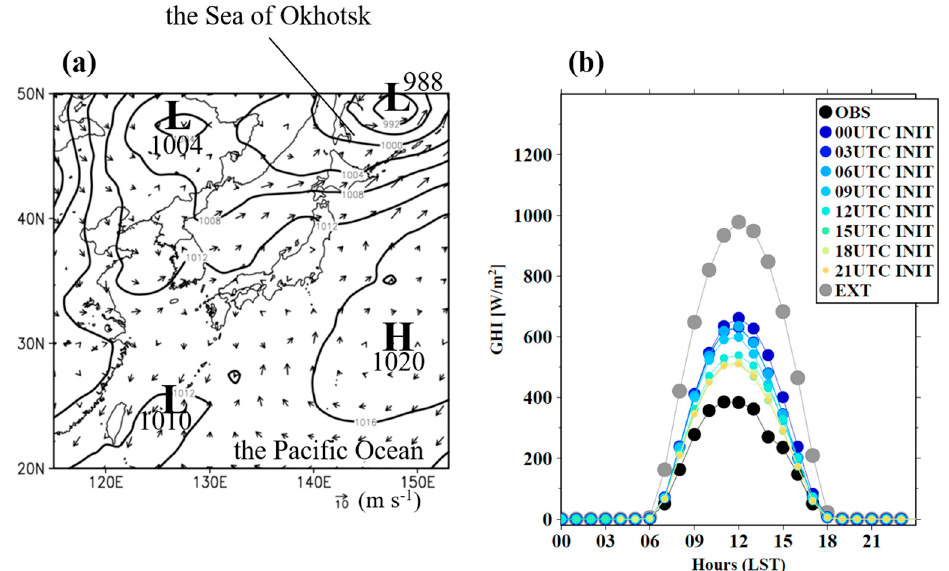
Figure 5. ( a ) Weather chart at 09 JST on 10 October 2015. ( b ) Time series of hourly GHI observations (black circles), meso-scale model (MSM) forecasts (colors), and extra-terrestrial solar irradiance on the same day for the integrated region of the nine electric power companies’ areas.